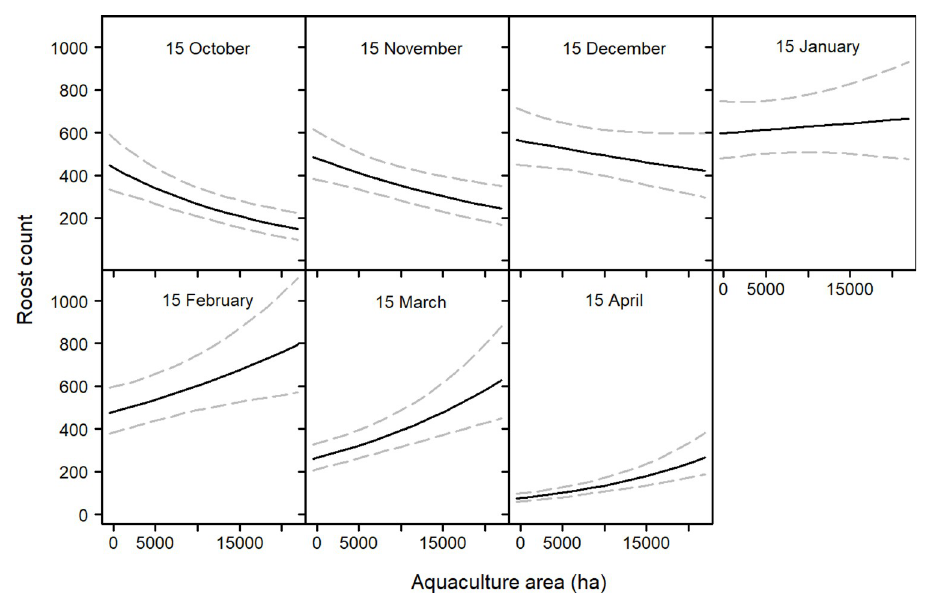
Fig 5. Average predicted abundance (+ 95% CI) of cormorants at roosting sites in the Mississippi Delta in relation to an interaction term of aquaculture area within a 23.4 km buffer and date. Trend lines were created from model predictions made by allowing each variable of interest to vary over its range and holding all other variables at their